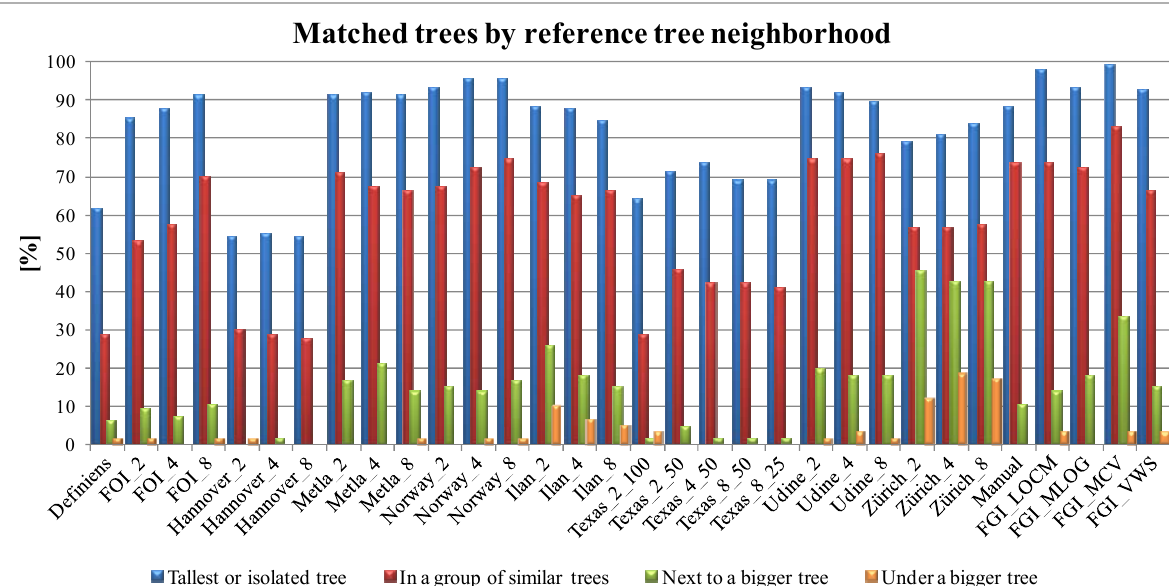
Figure 5. The impact of the tree neighborhood to tree matching.